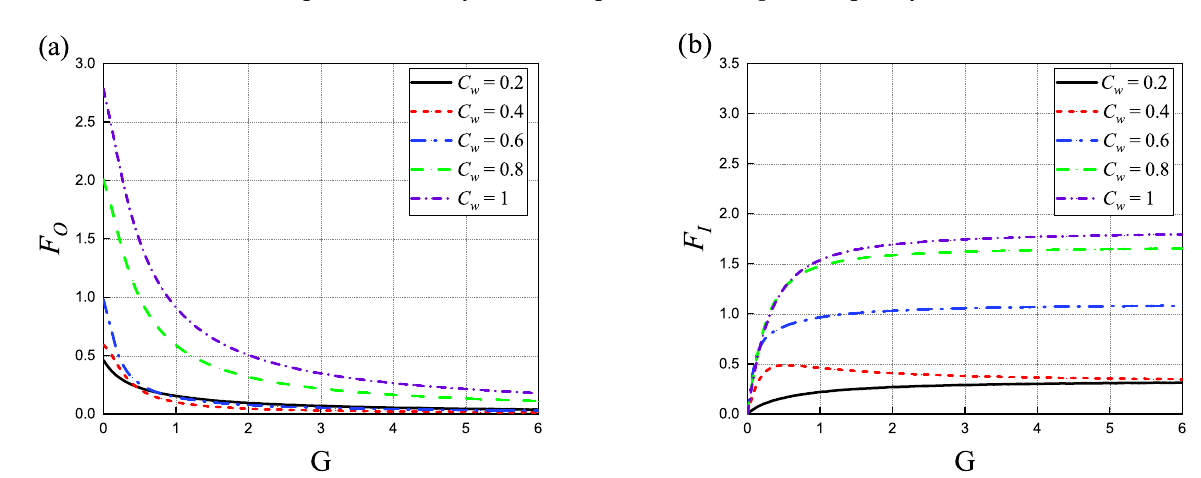
Figure 7. Hydrodynamic forces on the outer and inner cylinders versus G for different wave-effect parameters C w with e / a = 1, G 2 = 0, c / a = 0.5, β = 0, and h / a = 1.5: ( a ) the outer cylinder, ( b ) the inner cylinder.